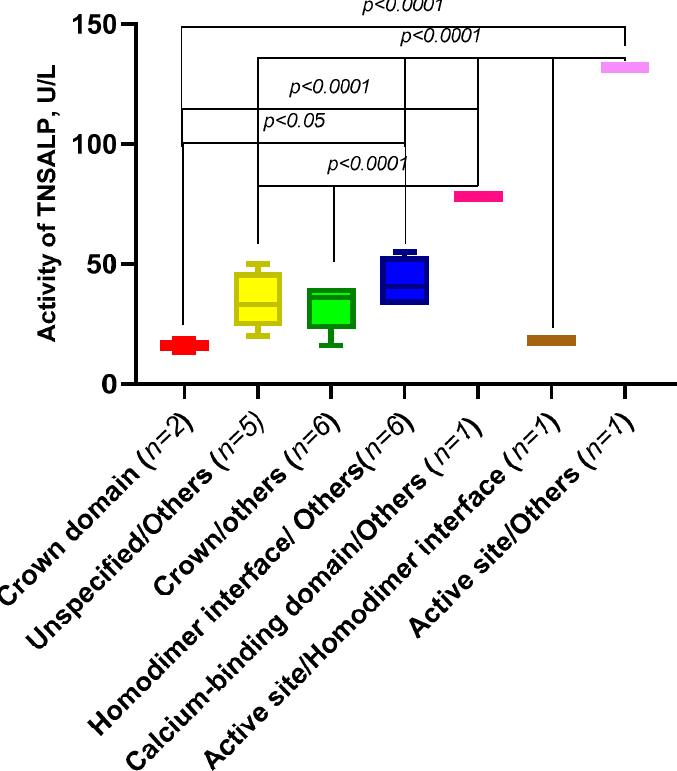
Figure 13. Activity of ALPL gene variants, depending on the protein domain location.